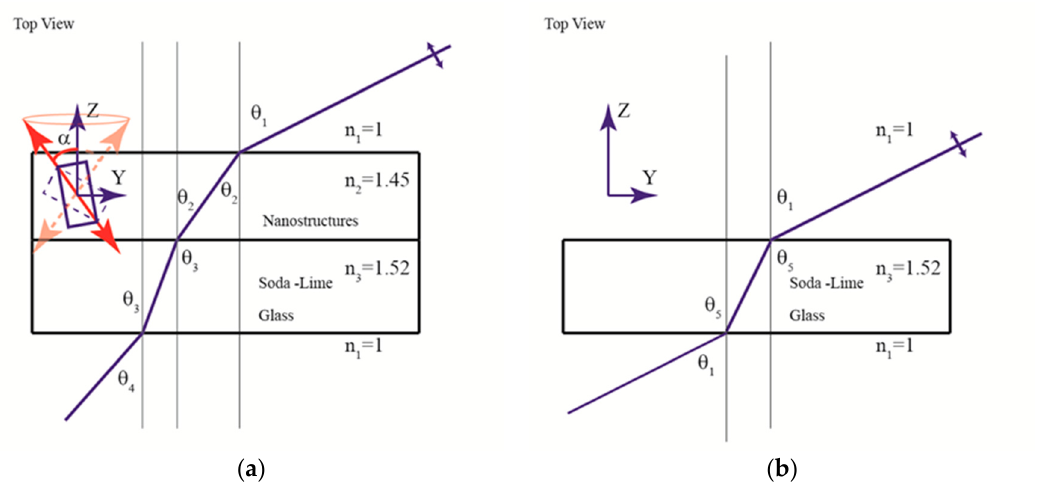
Figure A1. Sketch of the tilted plate setup for the thin films: ( a ) sample with spin casted nanostructures on glass; and ( b ) glass blank sample.